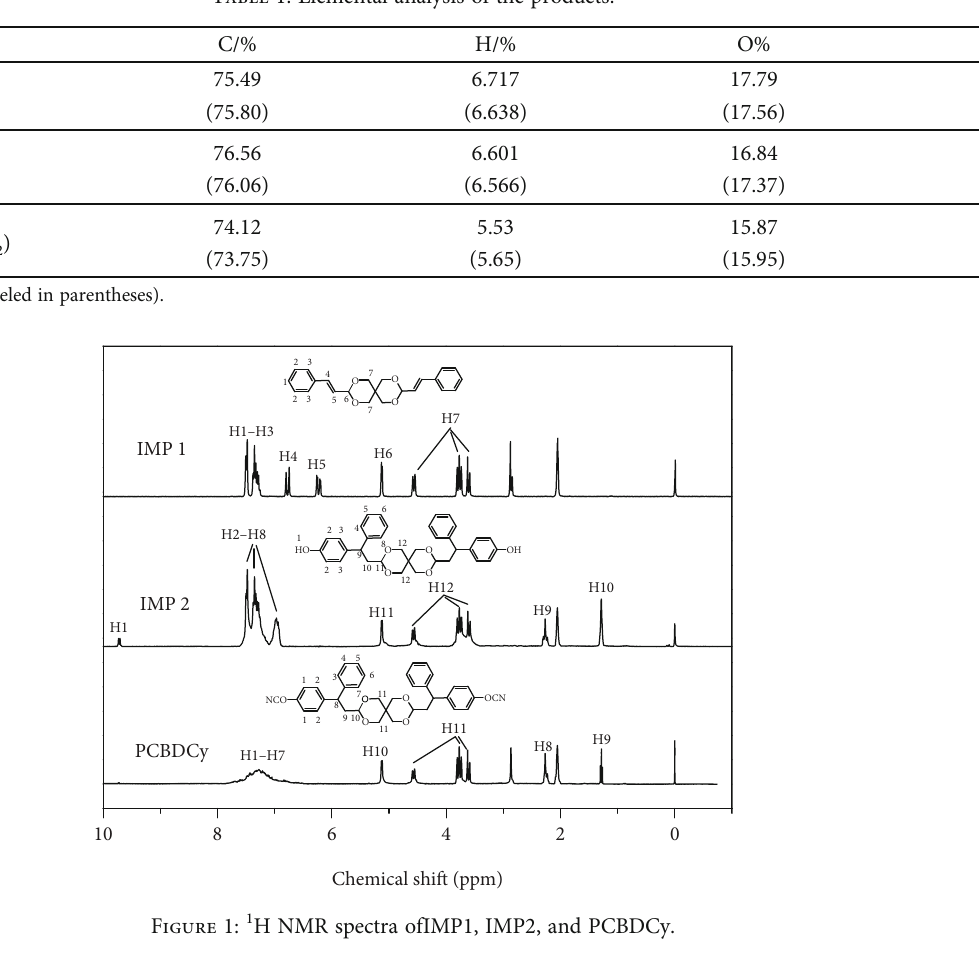
Table 1: Elemental analysis of the products.